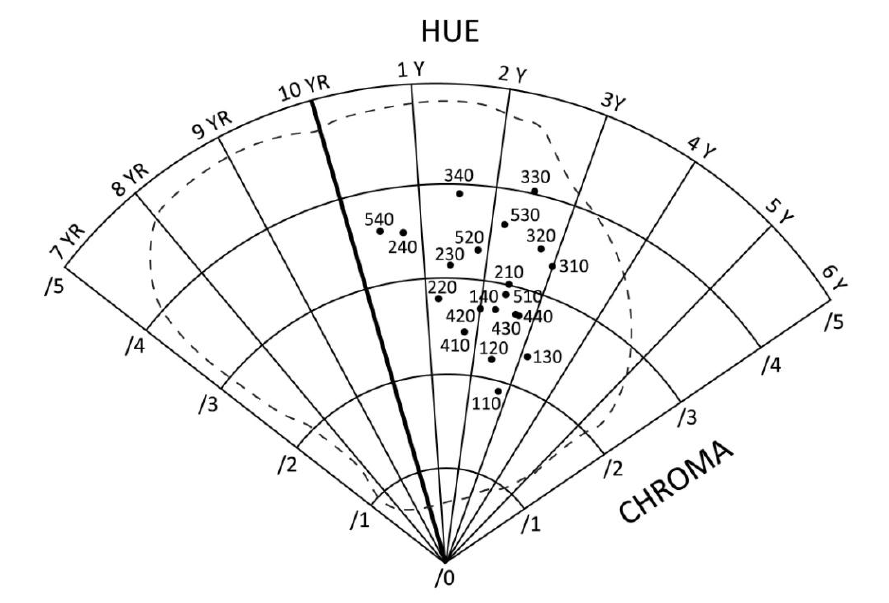
Figure 1. A plot of the Munsell hue and chroma for the master Chromascop shade guide. Note the dotted outline of color distribution of human teeth as plotted in a previous study [6].